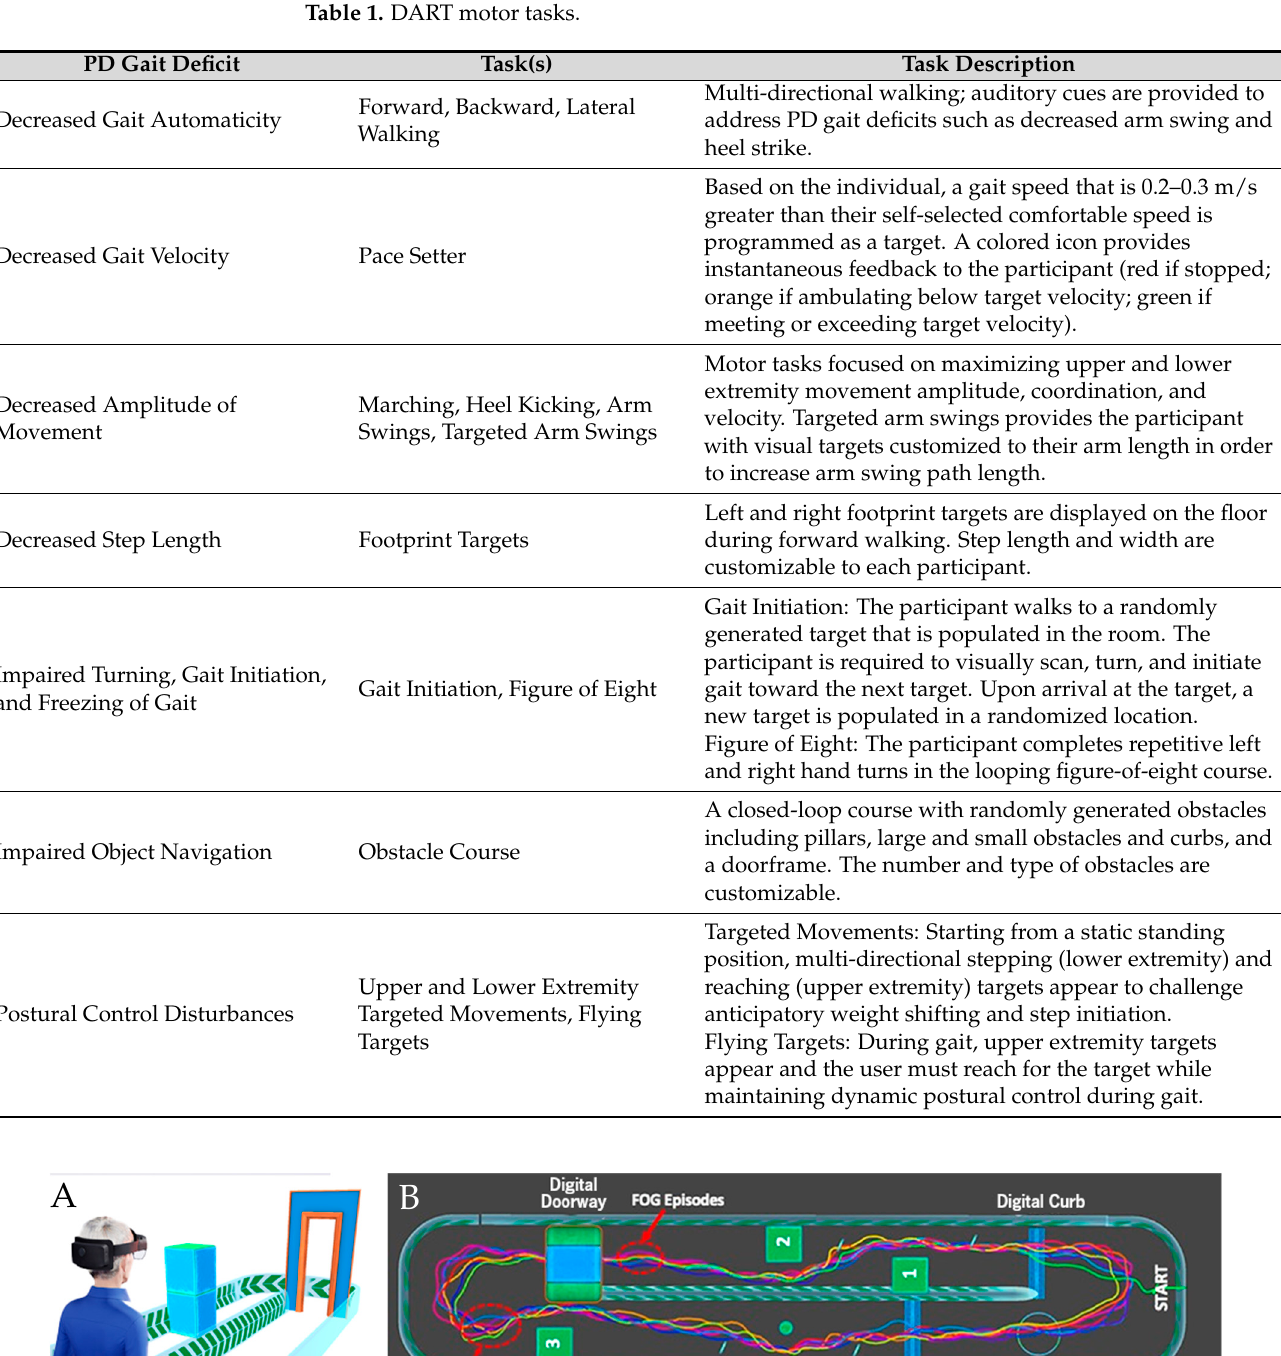
Figure 2. The Obstacle Course of the DART platform. ( A ) User view. The individual is presented with digital pillars, obstacles, curbs, and/or a doorway that must be navigated. To further increase task demands, a secondary cognitive task can be presented simultaneously and delivered by the HL2 DART platform. ( B ) A top-down view of the obstacle course with representative data from a single user. Each colored line represents one lap that the individual completed during a 180 s trial; the numbered boxes represent three pillars that required sidestepping to avoid. Freezing of gait (FOG) episodes, indicated by red circles, occurred prior to entering the doorway and at the end of the turn when presented with a narrowed passage.